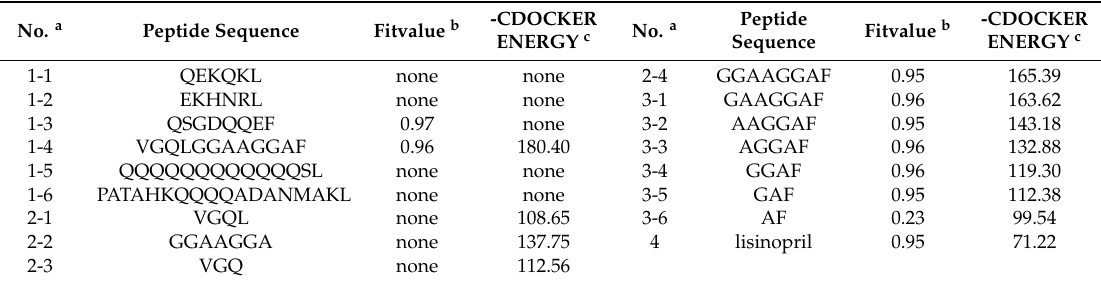
Table 2. The predicted results of peptides by pharmacophore and